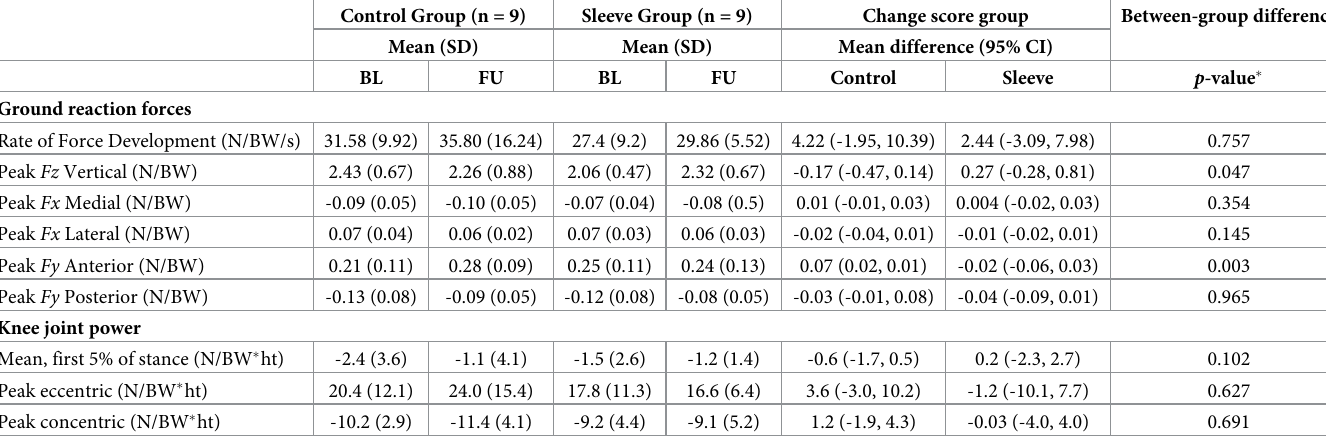
Table 3. Randomised clinical trial: Parameters of injured sides at baseline and follow-up, and between-group differences of changes from baseline to follow-up. Control Group (n =